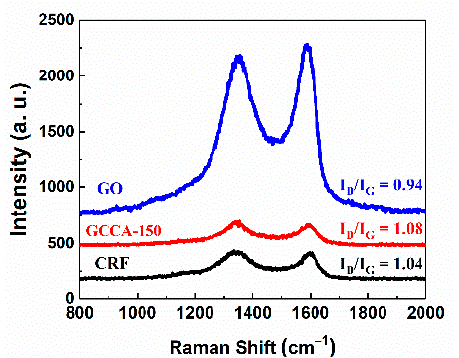
Figure 1. Raman spectra of GO, GCCA-150 and CRF (GO: graphene oxide; GCCA: graphene–composite carbon aerogel; CRF: pure carbon aerogel derived from the polycondensation of R and F).